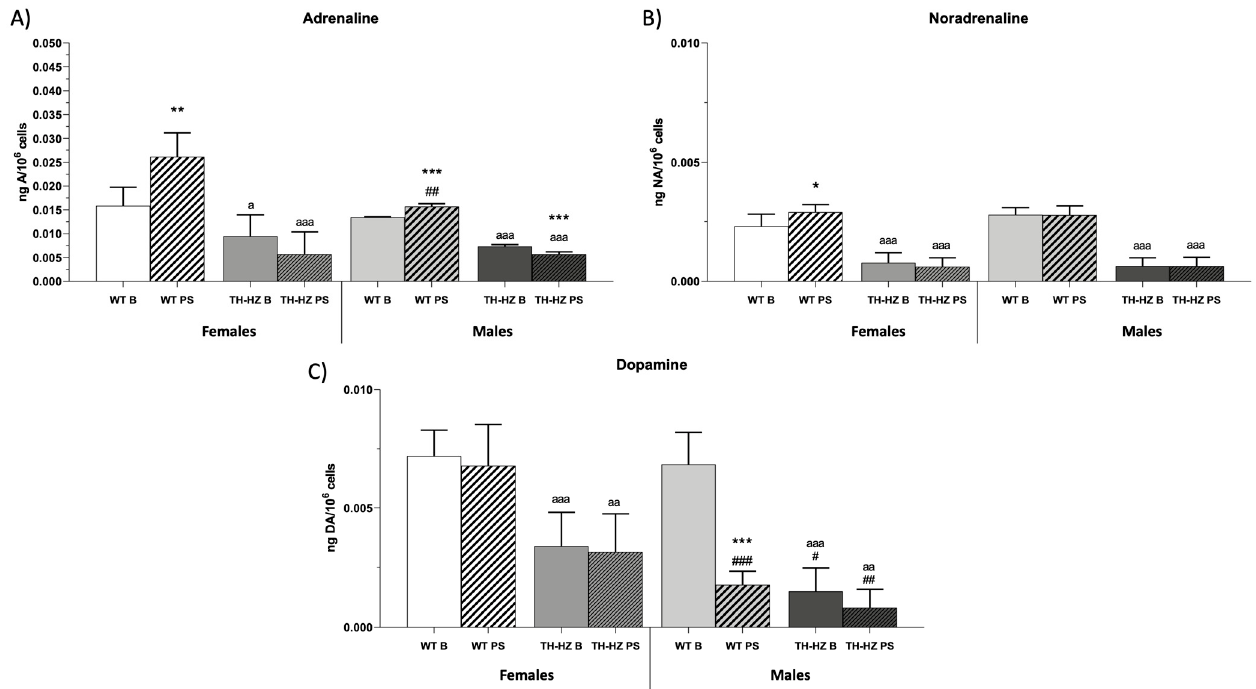
Figure 6. Catecholamine concentrations. ( A ) Adrenaline (ng A/10 6 cells). ( B ) Noradrenaline (ng NA/10 6 cells). ( C ) Dopamine (ng DA/10 6 cells). Each column represents the mean ± standard deviation of values corresponding to 6 animals. * p < 0.05, ** p < 0.01, *** p < 0.001 compared to basal condition, a p < 0.05, aa p < 0.01, aaa p < 0.001 compared to WT. # p < 0.05, ## p < 0.01, ### p < 0.001 compared to female. WT B: Wild type basal. WT PS: Wild type post-stress. TH-HZ B: TH-HZ basal. TH-HZ PS: TH-HZ post-stress.